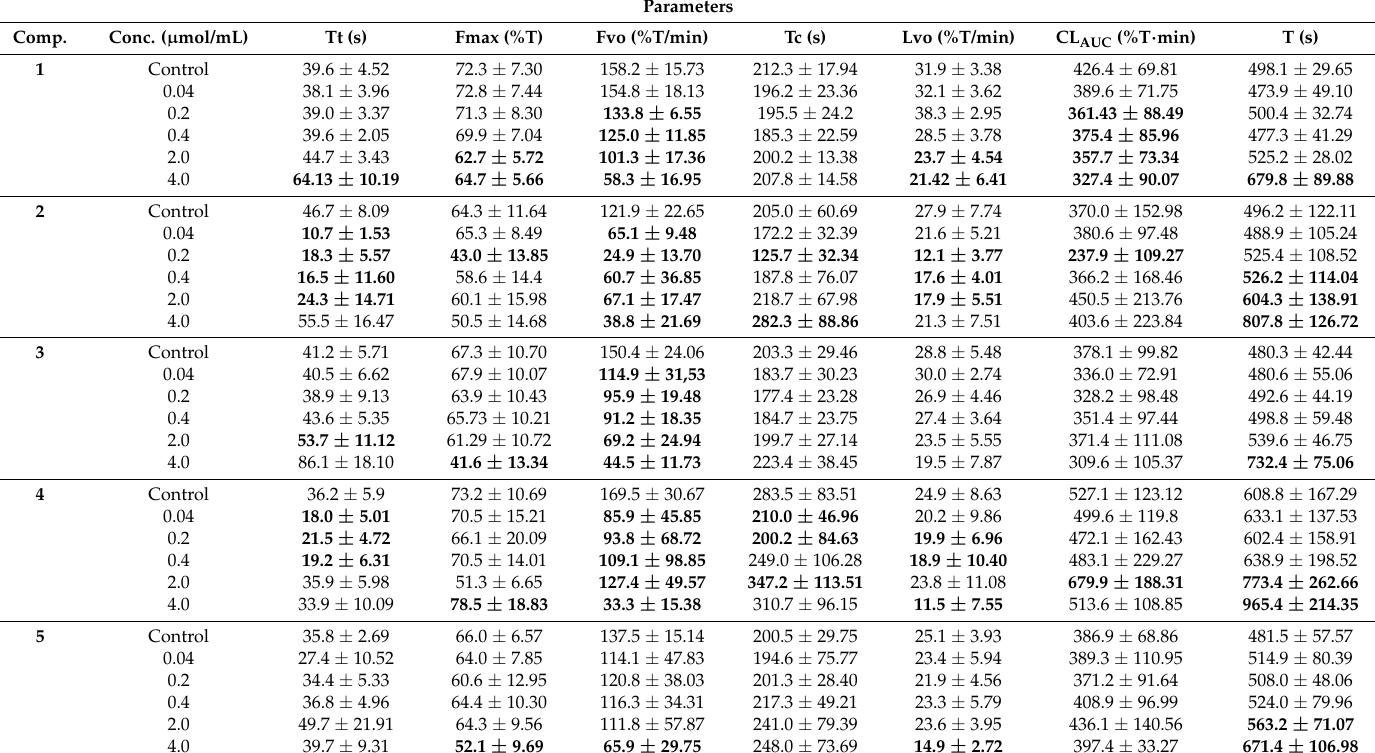
Table 3. The effects of synthesized iminodiacetic acid derivatives on the kinetic parameters of clot formation and fibrinolysis (CL-test).